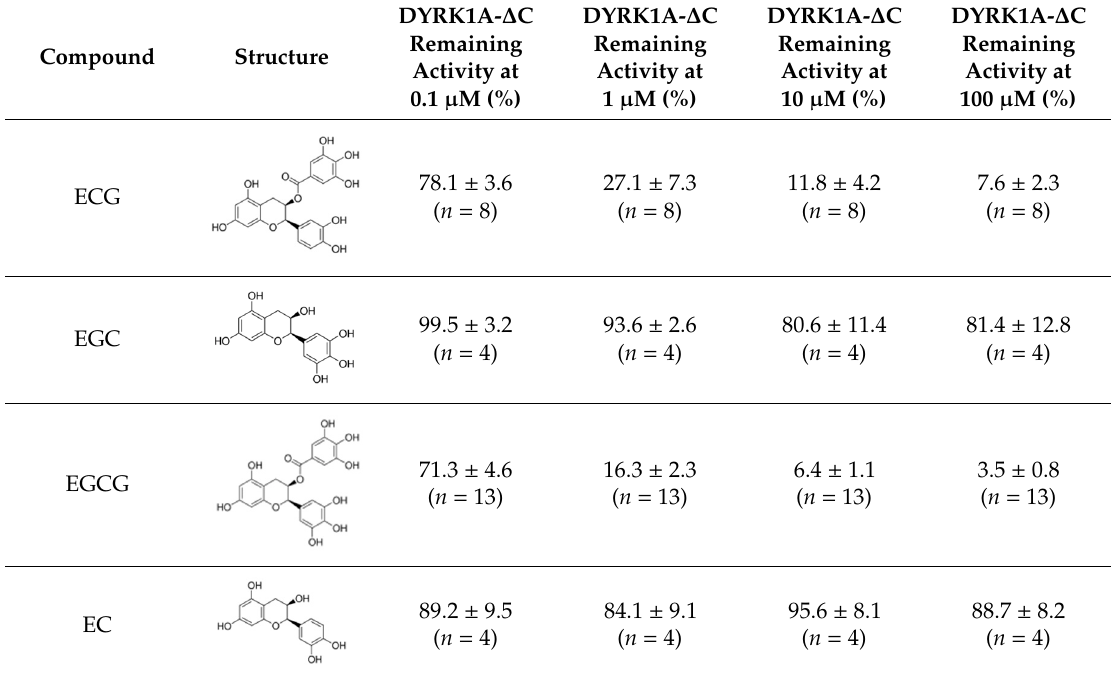
Table 1. DYRK1A- Δ C inhibition assay at different concentrations using HPLC-based assays. Table 1. DYRK1A- ∆ C inhibition assay at di ff erent concentrations using HPLC-based assays.